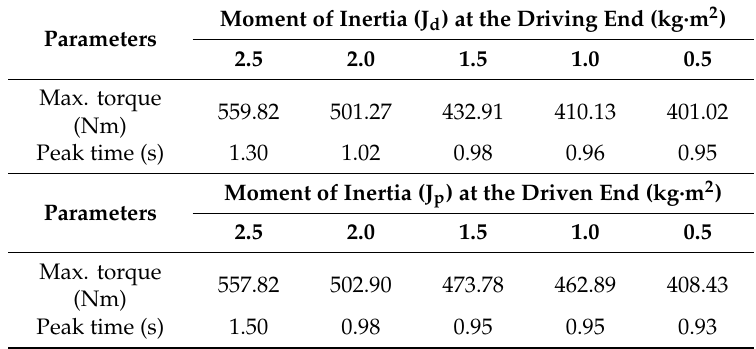
Table 5. The times of peak torques at a di ff erent moment of